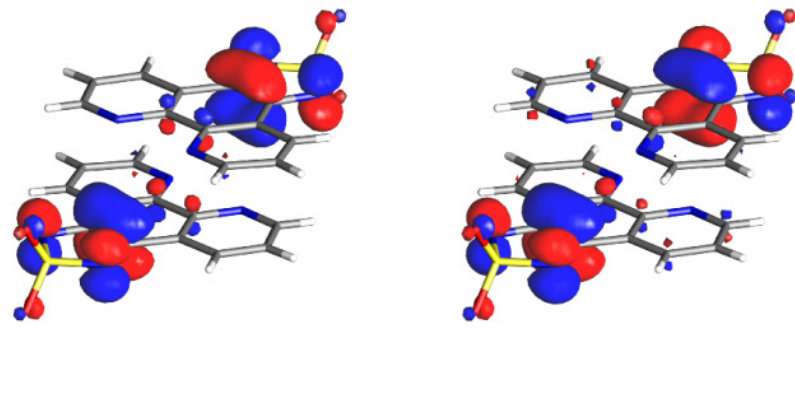
. Adapted with permission 2